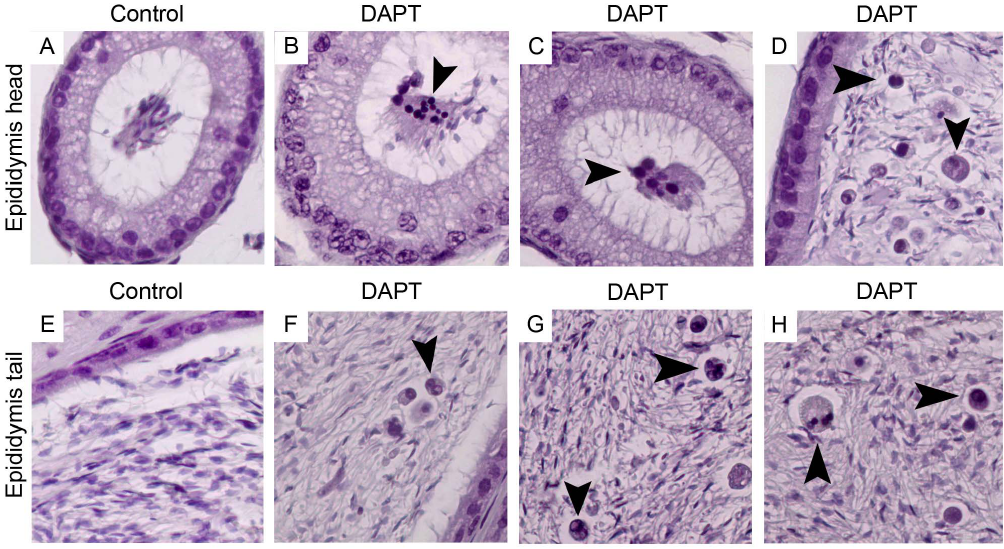
Figure 6. Abnormal germ cells are released into the epididymis lumen. Staining with haematoxylin (400x magnification). Tissue sections from epididymis head and tail lumen of control (A and E) and DAPT treated (B–D and F–H) mice. DAPT treated mice show abnormal germ cells in the epididymis lumen. Arrow heads point abnormal germ cells. doi:10.1371/journal.pone.0113365.g006 PLOS ONE |